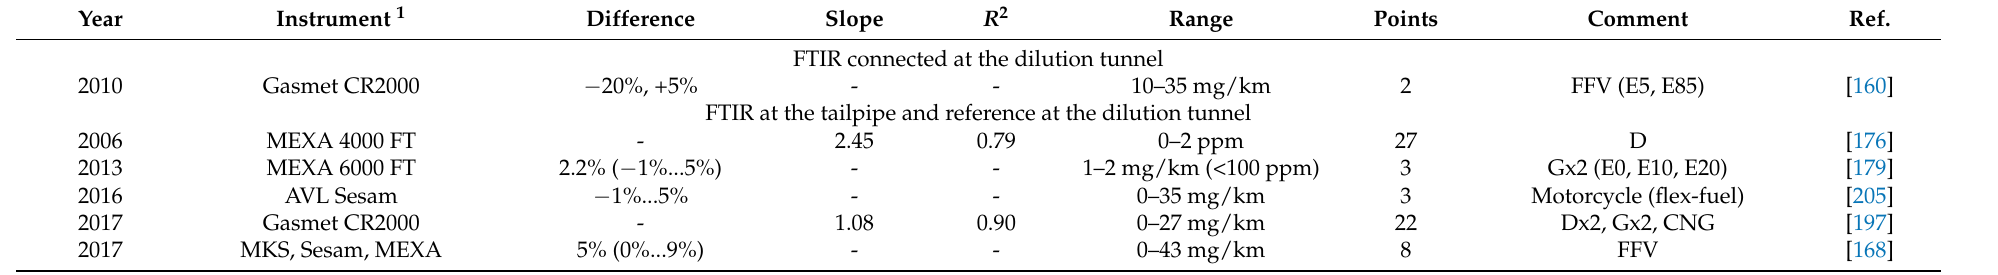
Table A9. Comparisons of FTIR with acetaldehyde (CH 3 CHO) methodology (DNPH +